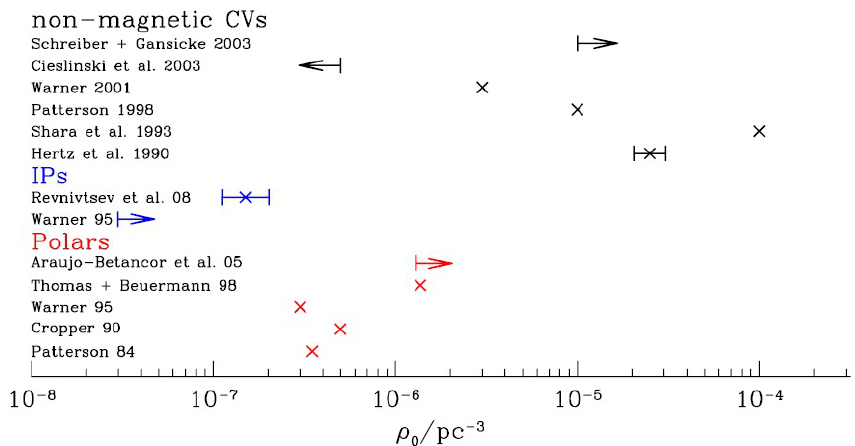
Figure 1: Some previously reported measurements of the space densities of different CV